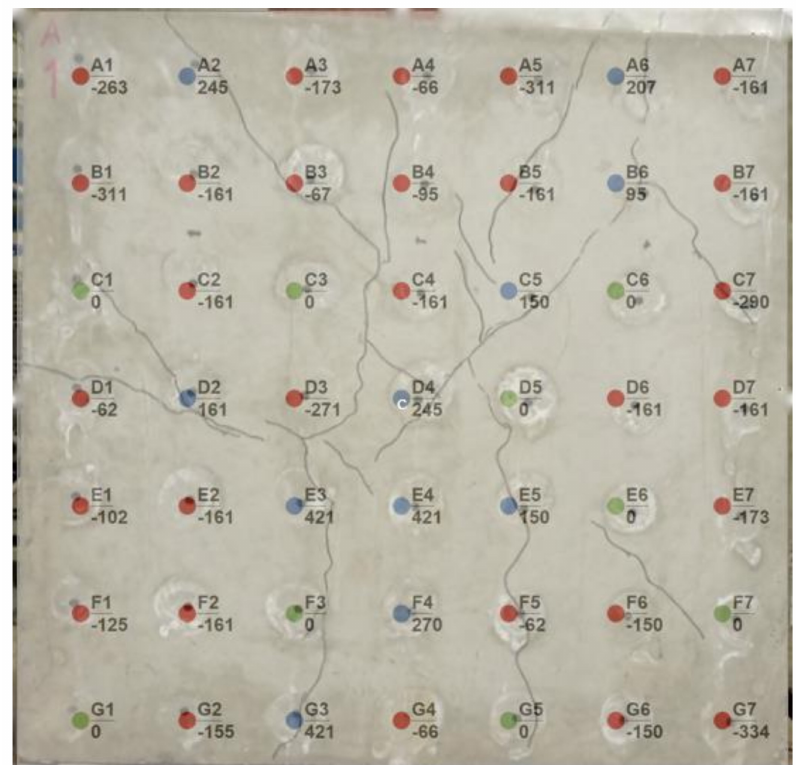
Figure 9. Schema of differences in measured velocities [m · s − 1 ] of ultrasound wave for specimen A2_3 before and after blast load of 600 g TNT: acceleration (red color)–52.9% of